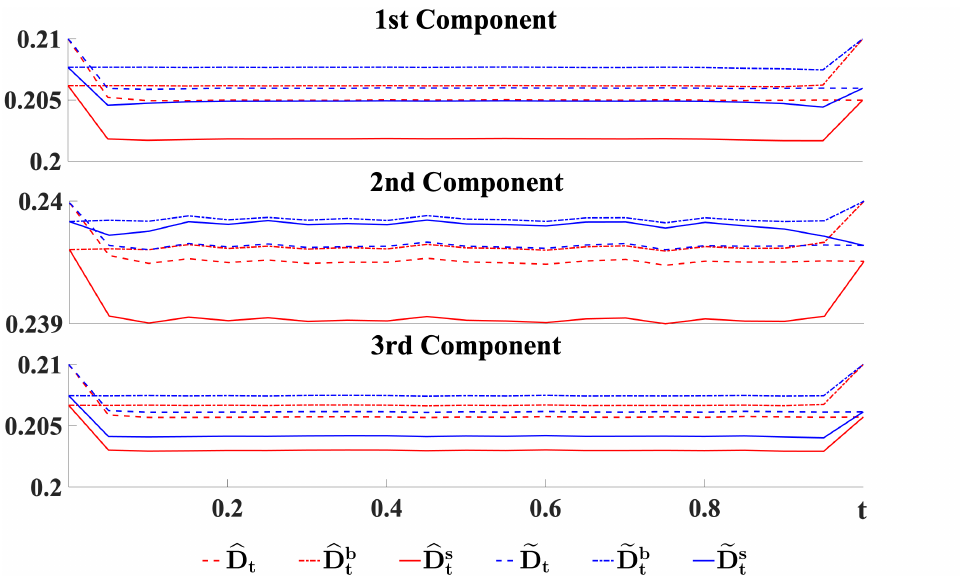
Figure 1. Sample error variances of the proposed estimates and the ones from